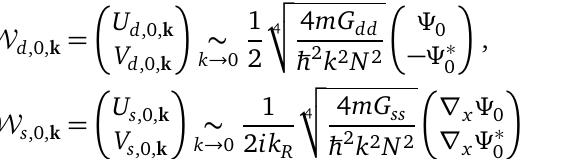
Figure 2: Sound velocity as a function of the Raman coupling Ω excitations propagating parallel (perpendicular) to the x axis are shown in panel (a) [ (b) ] . The solid curves represent the exact numerical values, the dashed ones corre- spond to the perturbation results obtained for the density (blue) and spin (red) gap- less mode. The vertical dotted lines mark the critical Raman coupling ħ h Ω at which the transition to the plane-wave phase takes place. The interaction param- eters are the same as Fig.